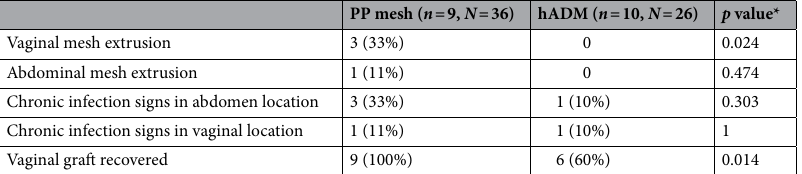
Table 1. Macroscopic study of explants. N number of animals explanted, n number of analyzed samples. * p < 0.05.